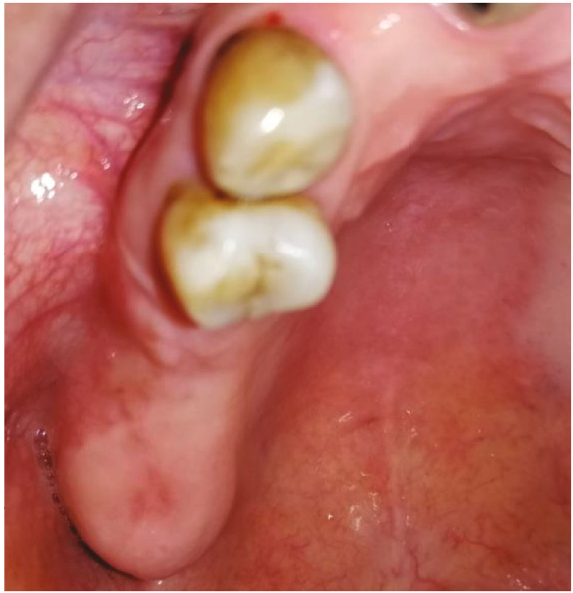
Figure 5: Intraoral view showing healing at one month.